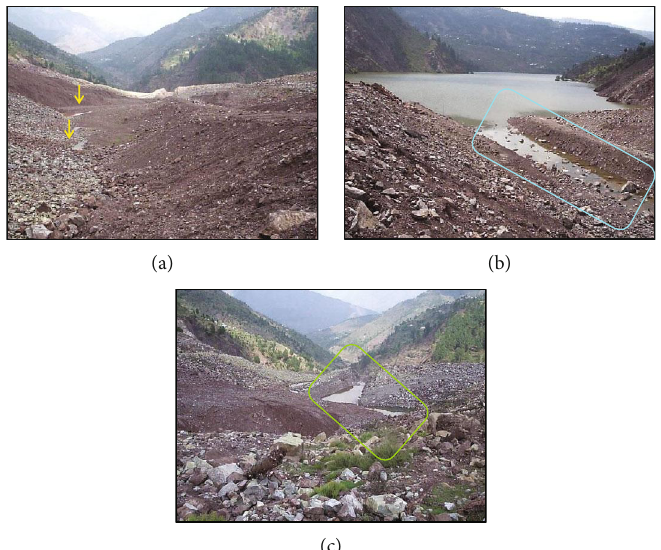
Figure 9: Photographs showing (a) locations of seepage points along the downstream slope of the dam (February 2007); (b) Karli lake fi lled to its capacity overtopping through segment 1 of Karli spillway (April 2007); (c) overtopping water from Karli lake fl owing through segment 3 of Karli spillway (April